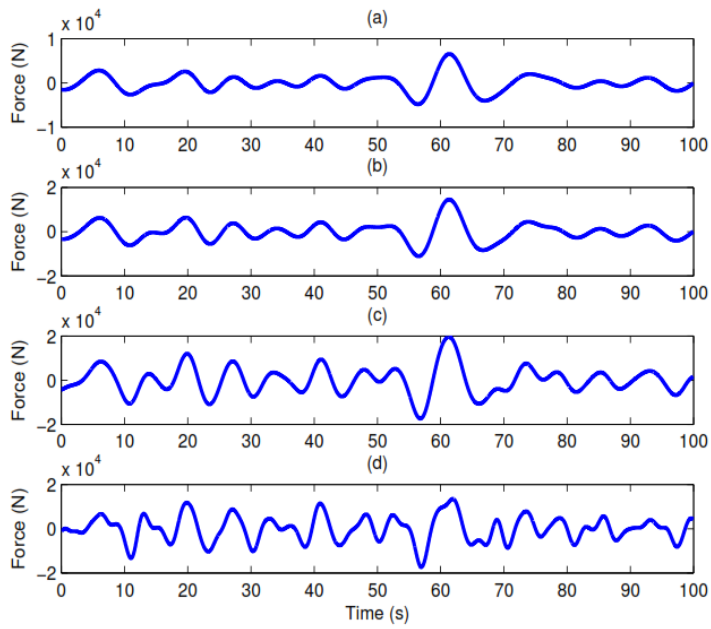
Figure 10. The wave loads at different elevations: ( a ) −33 m, ( b ) −22 m, ( c ) −11 m, and ( d ) 0 m.